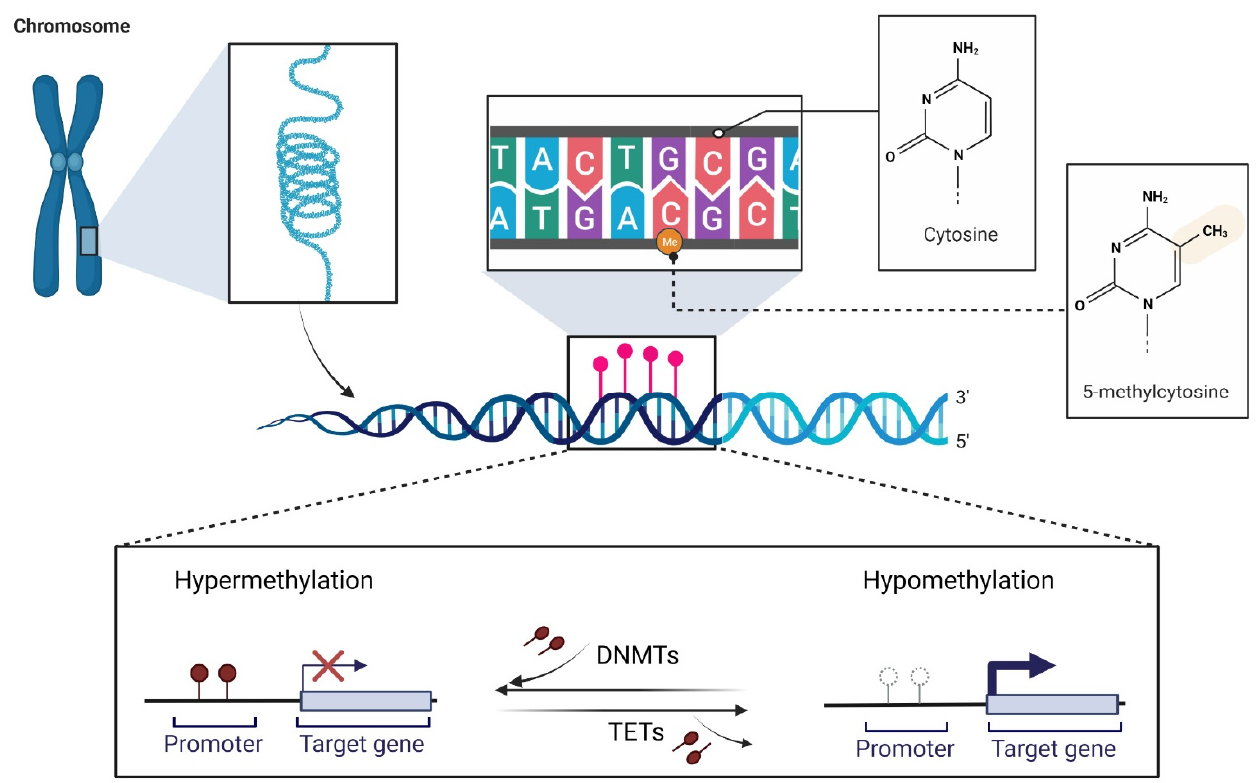
Figure 1. Schematic mechanism of DNA methylation and demethylation. In the DNA sequence, unmethylated cytosines are converted to 5’-methylcytosines (addition of the -CH3 group) by DNMTs. This event encompasses the CpG islands enriched in gene promoters and is generally associated with gene silencing. This reaction is potentially reversible due to the activity of TET enzymes, resulting in the loss of DNA methylation (hypomethylation). The white circles indicate unmethylated CpG sites, and the red circles denote methylated CpG sites. The crossed arrow on the left indicates the absence of transcription after DNA promoter methylation. The thick arrow on the right indicates the start of gene transcription as a consequence of promoter demethylation. Abbreviations: DNMTs, DNA methyltransferases; TETs, ten-eleven translocation methylcytosine dioxygenases. The above diagram was created using BioRender (https://biorender.com/ (accession date 8 October 2021)).